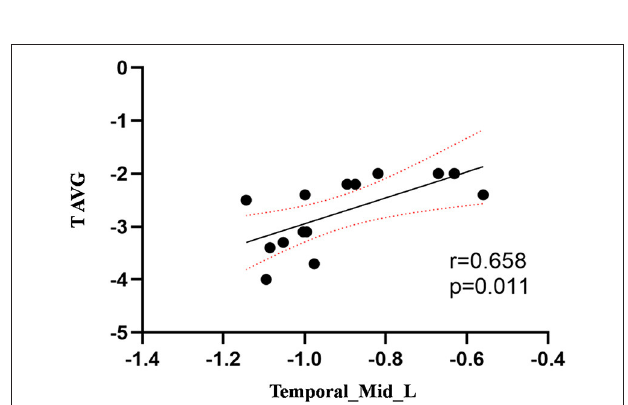
and right SPL showed a negative correlation with MOCA scores, the ReHo values of right SPL showed negative correlation with OC level.